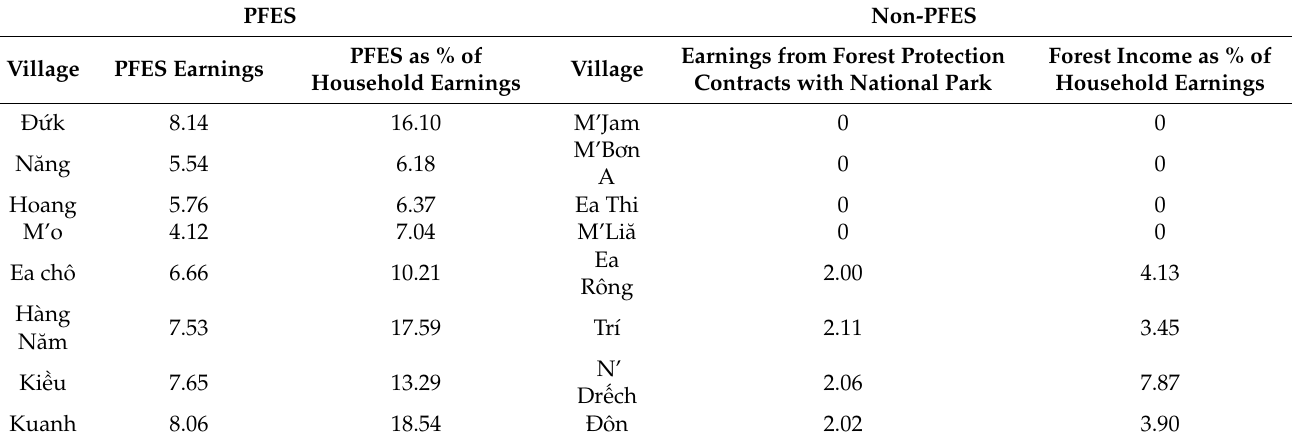
Table 6. Contributions of forest protection activities and PFES to household earnings (VND × million). PFES